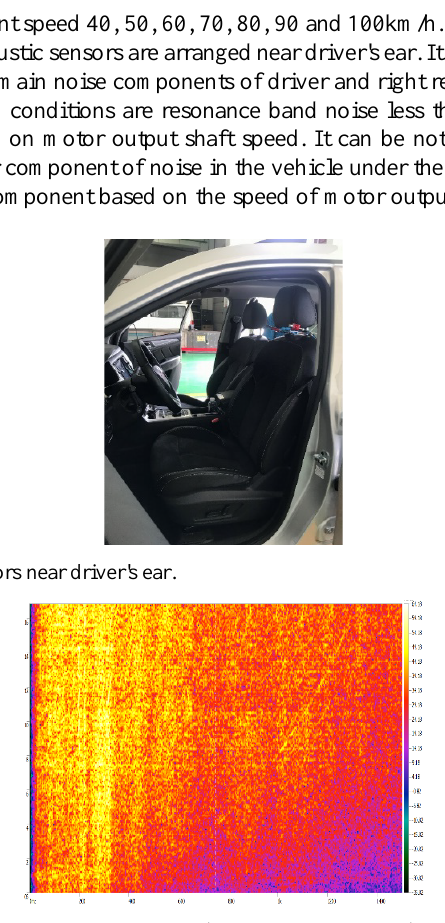
Fig. 7. Driver's external ear noise order analysis (acceleration condition).